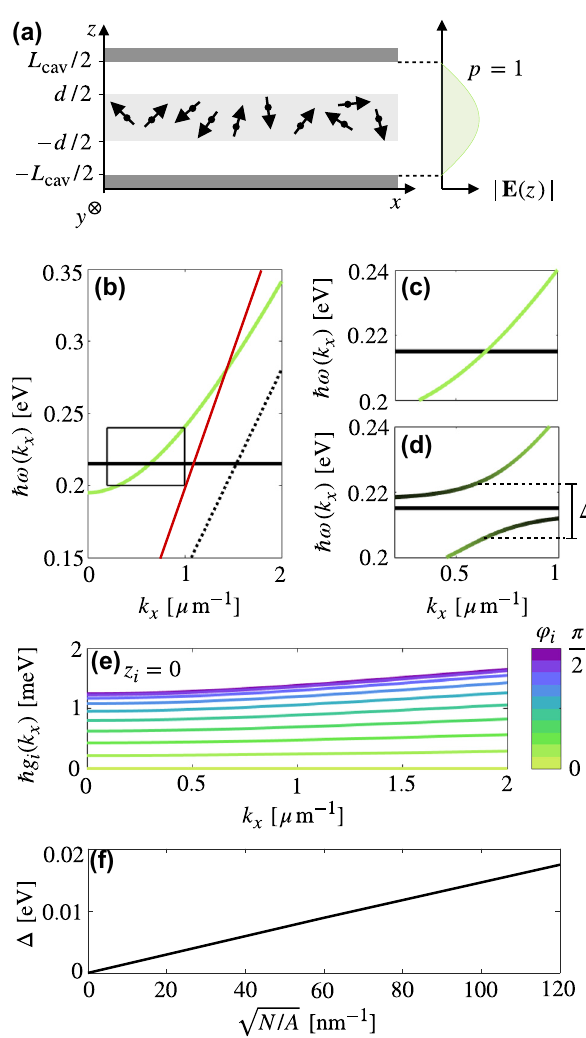
Figure 1: Strong coupling of molecules to a planar cavity mode: (a) Schematic showing a slab (of thickness d ) of transition dipoles in and (b) the dispersion relation of N C = O a cavity of thickness L cav = 0.215 eV, and a cavity units, with transition resonance ℏ𝜔 mol = 2.26 μ m), mode, with no molecule/cavity coupling. Light-line ( L cav in air given by red line, light-line in PMMA given by dotted black line. (c) Zoom-in of overlap between modes without and (d) with strong coupling. PMMA density N ∕ A = 1.58 × 10 4 nm − 2, slab thickness d = L cav = 2.26 μ m, dipoles aligned with electric field such that all 𝜗 = 𝜑 = 𝜋 ∕ 2. Δ is the magnitude of the gap at the resonant i i frequency. The dark states can be seen as a dispersionless band of . (e) Magnitude of the coupling constant for a frequency 𝜔 mol = 0 and varying dipole alignment from along molecule at position z i the x axis (such that 𝜑 = 0, 𝜗 = 𝜋 ∕ 2) to along the y axis (such that 𝜑 = 𝜋 ∕ 2, 𝜗 = 𝜋 ∕ 2). (f) Varying the interaction strength by varying PMMA density N ∕ A , we see that the size of the avoided crossing gap √ is proportional to N ∕ A